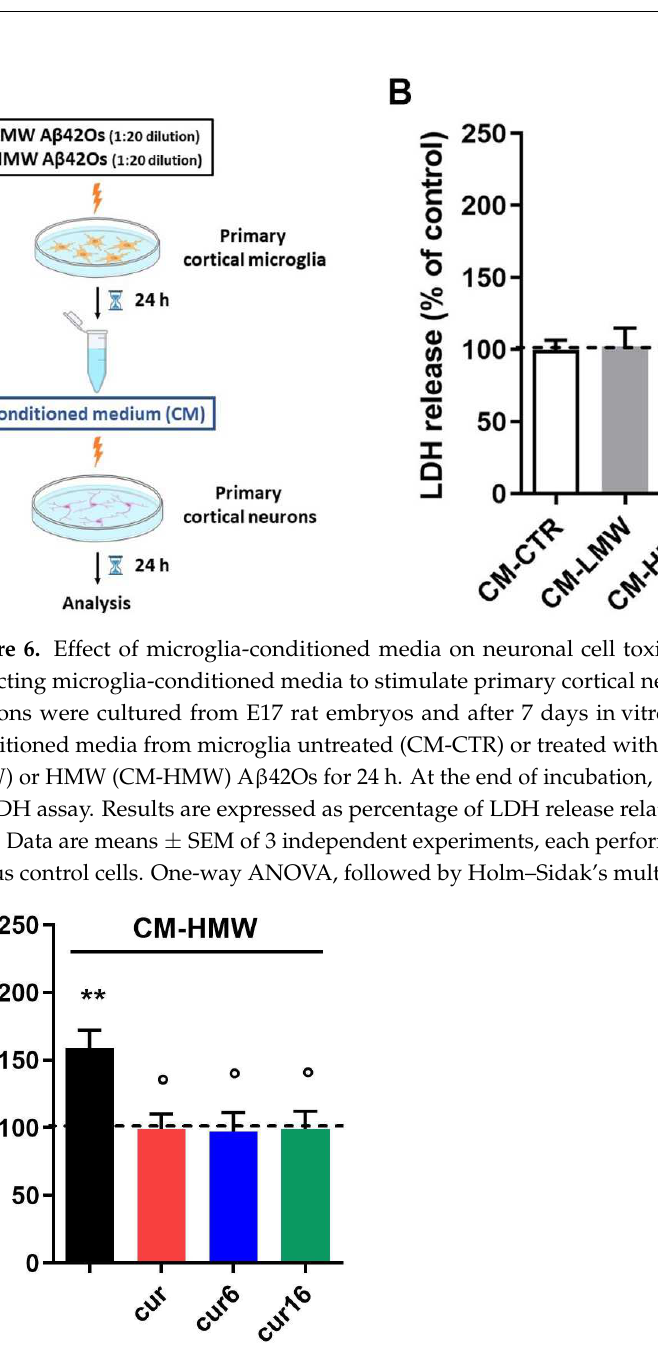
Figure 7. Effect of conditioned medium from microglia treated with curcumin and analogues on neuronal cell toxicity. Primary cortical neurons were cultured from E17 rat embryos and after 7 days in vitro were exposed for 24 h to conditioned media from microglia pretreated with 10 µM curcumin (cur), cur6 , or cur16 before stimulation with HMW (CM-HMW; 1:20 dilution) A β 42Os for 24 h. At the end of incubation, cell viability was determined by LDH assay. Results are expressed as percentage of LDH release relative to control cells (dashed line). Data are means ± SEM of 3 independent experiments, each performed in duplicate. ** p ˂ 0.01 versus control cells and ° p ˂ 0.05 versus CM-HMW. One-way ANOVA, followed by Holm – Sidak’s multiple comparison test.